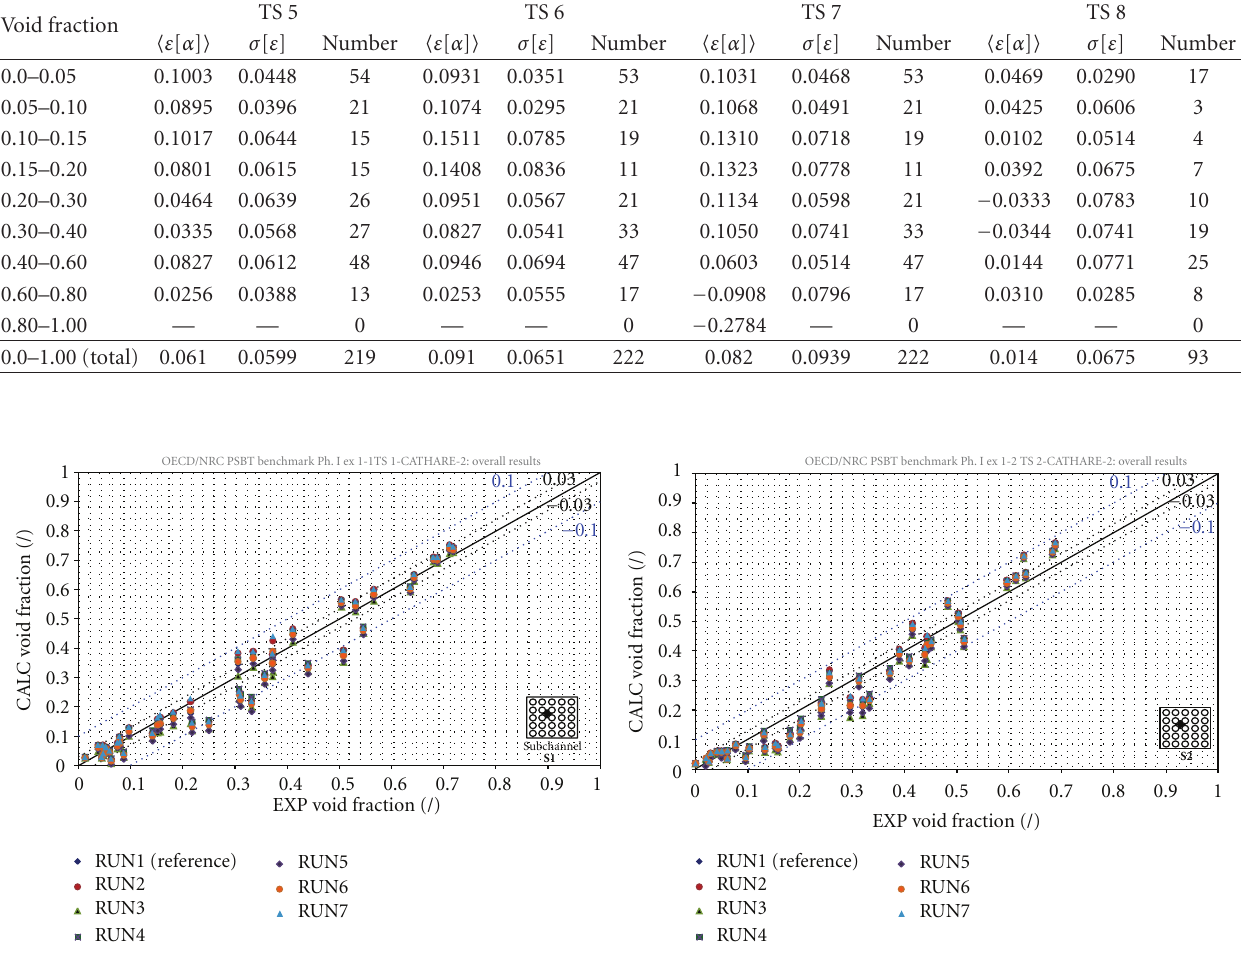
Table 5: PSBT steady-state bundles (TS 5, TS 6, TS 7, TS 8,): summary of reference calculations results by CATHARE2 3D model.